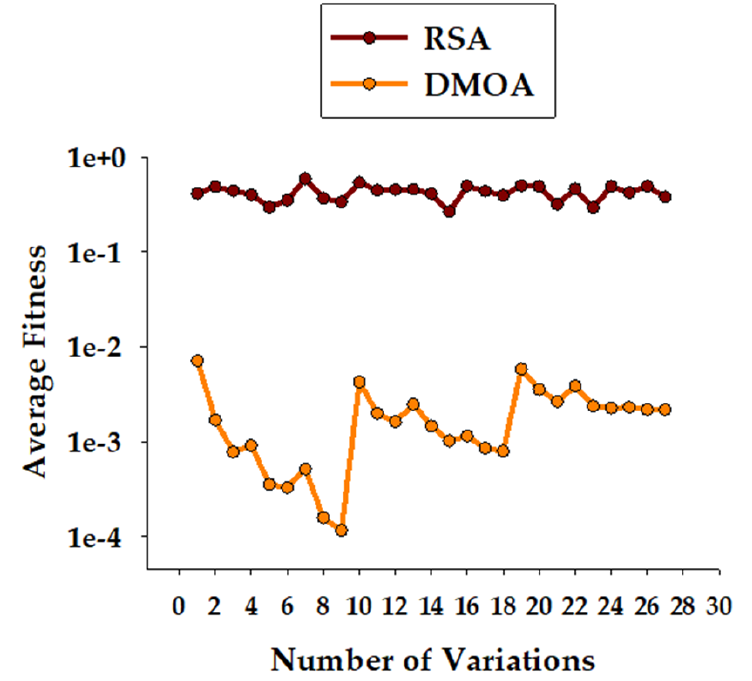
Figure 10. Kruskal–Wallis test between the DMOA and RSA, where p < 0.01.